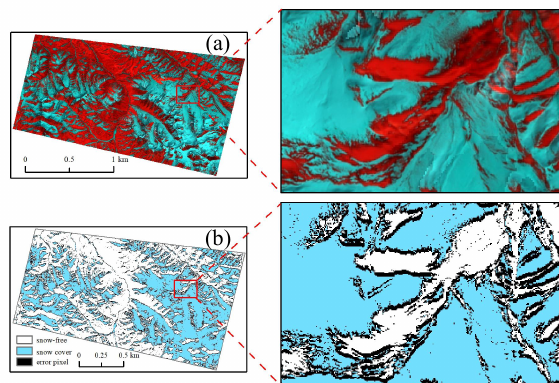
Figure 9 . Error distribution map of dynamic threshold snow cover extraction .(a) Sentinel-2 false color image; (b) error distribution map